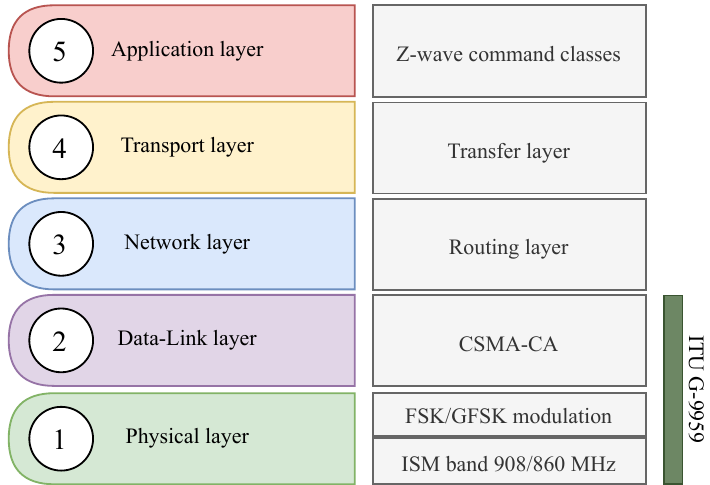
Figure 9. Comparing Z-wave stack with OSI